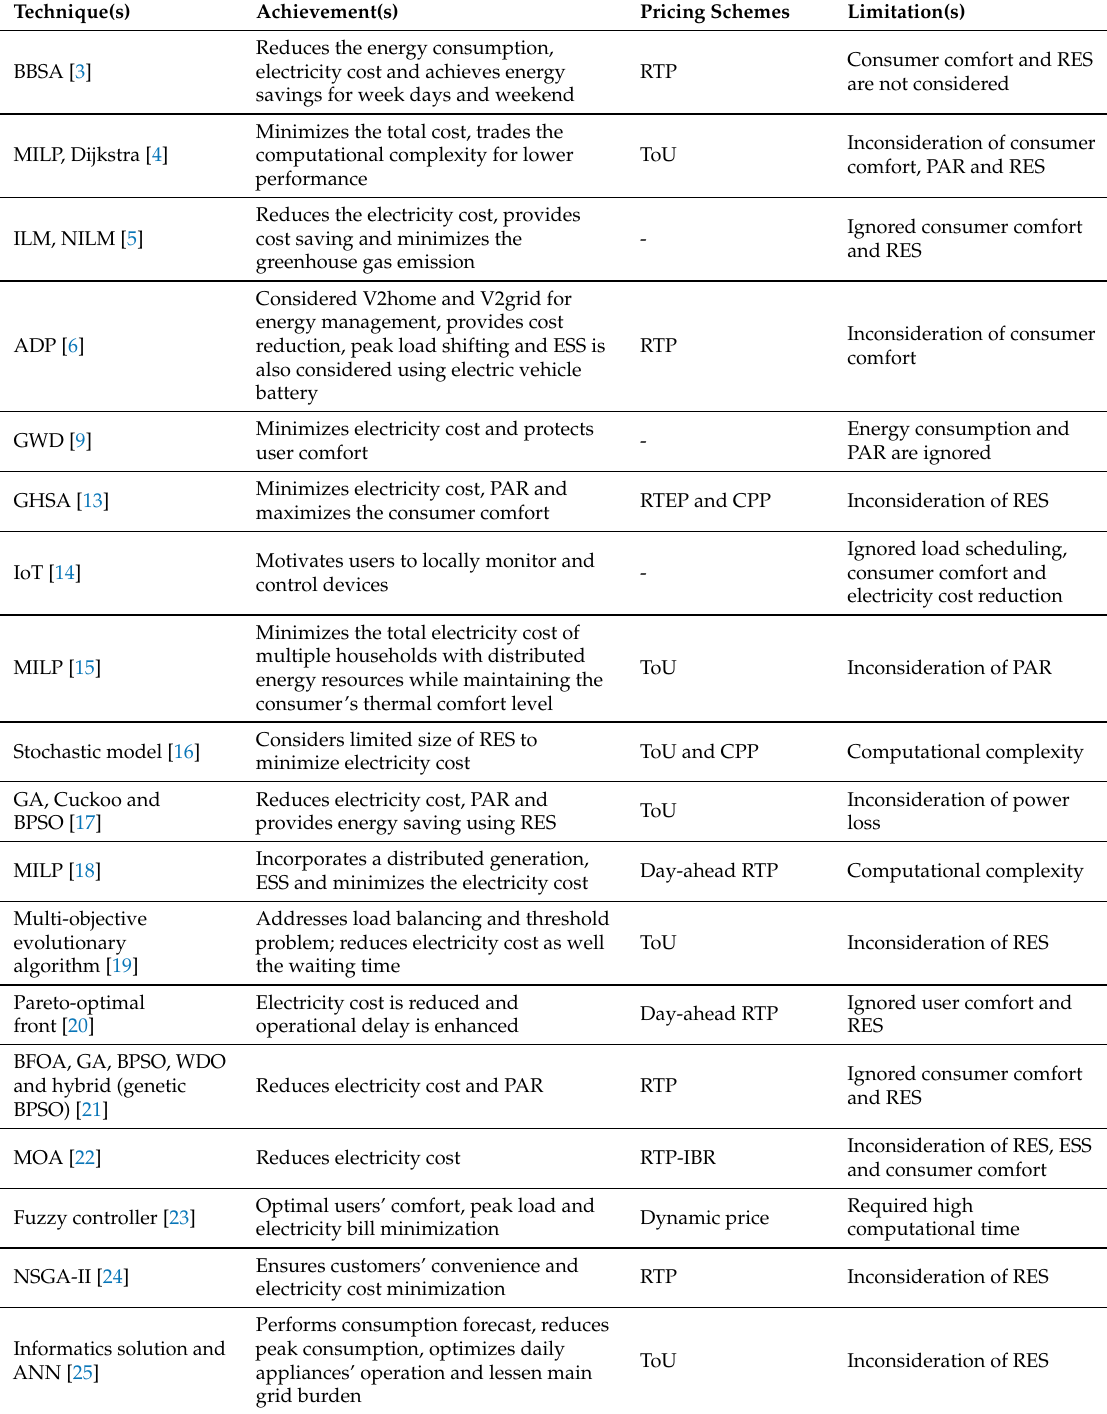
Table 1. Summary of related